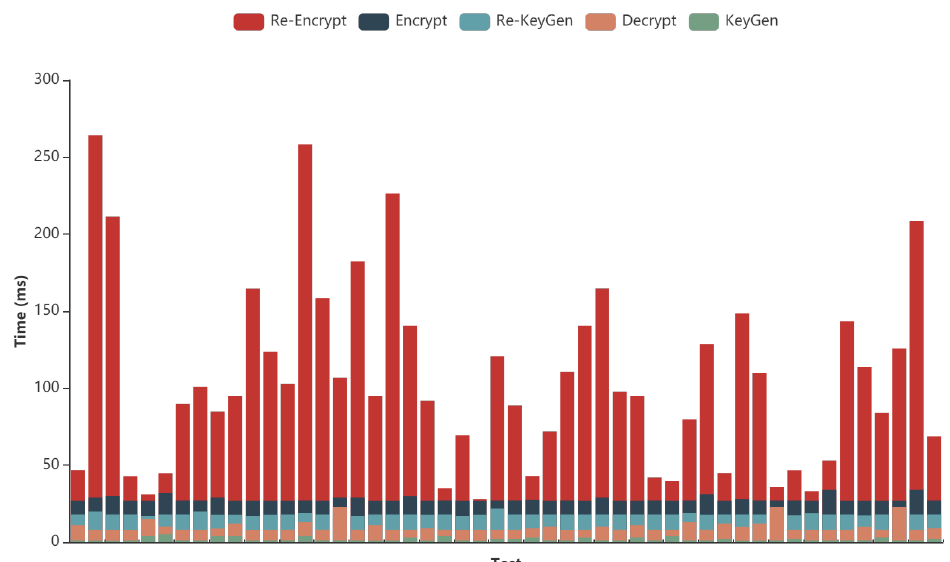
Figure 6. The time consumption in different stages of data sharing.